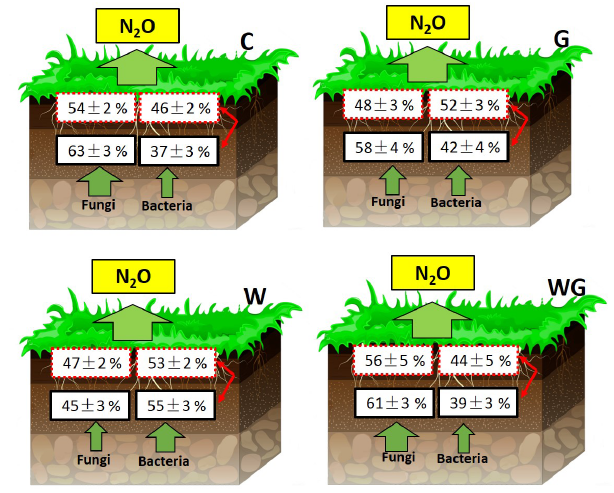
Figure 5. Contribution of bacteria and fungi to total nitrification enzyme activity (box with the red and dashed line) and total poten- tial of N 2 O production from denitrification (box with the black and solid line) in an alpine meadow. C (black bar), control treatment; G (white bar), winter grazing treatment; W (white-dotted bar), warm- ing treatment; WG (black-dotted bar), warming combined with the winter grazing treatment. Values are means ± 1s.e.m. ( n =